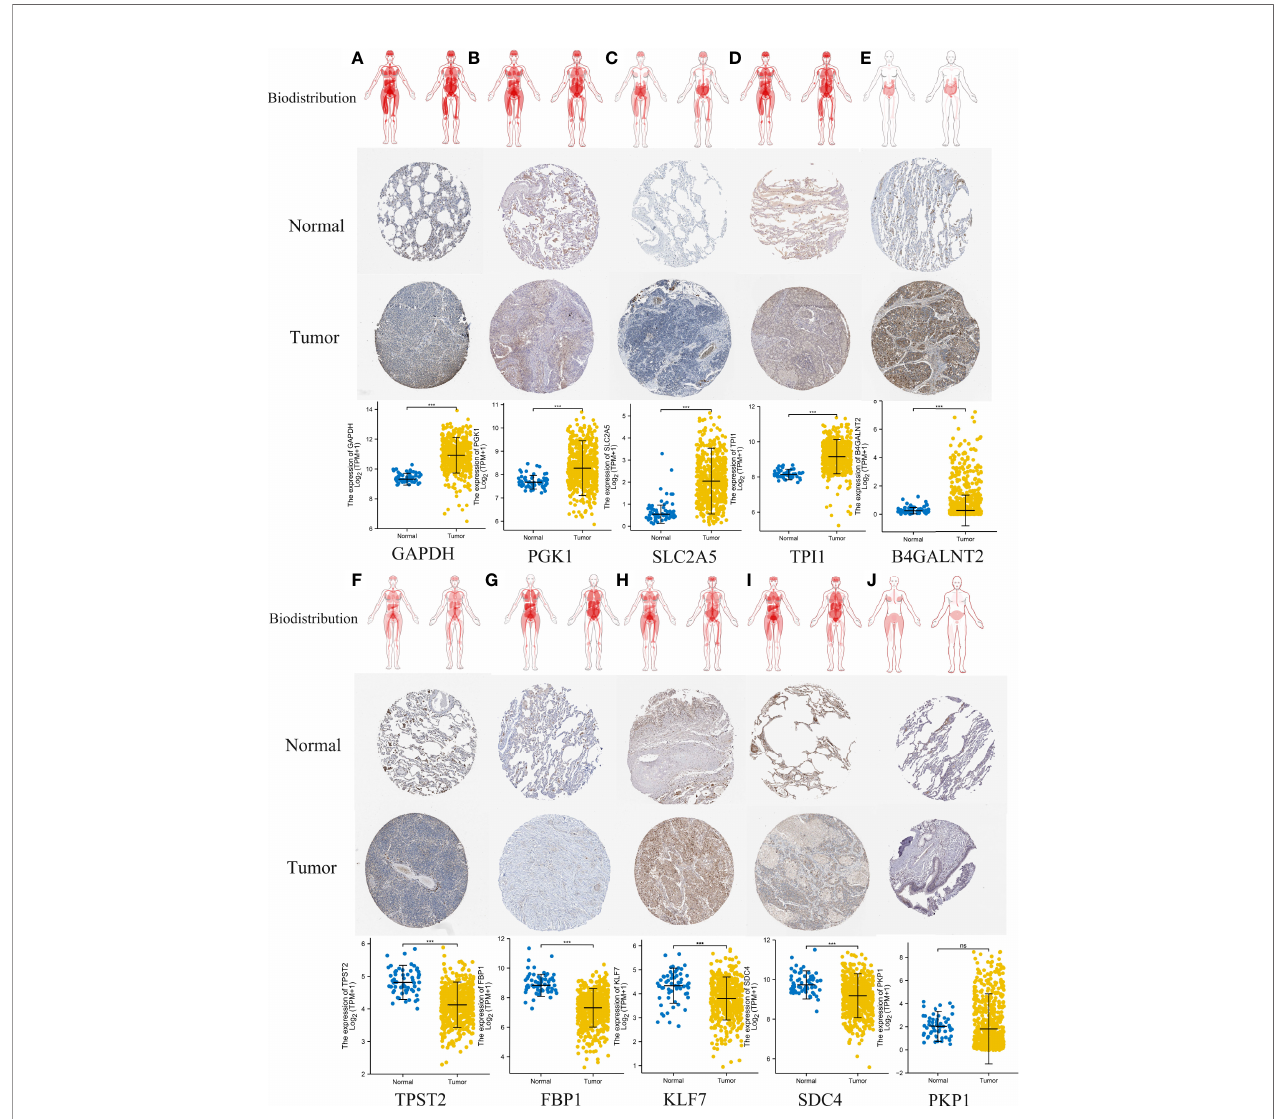
FIGURE 13 | Comparison of hypoxia-associated gene expression at the protein level. From top to bottom, panels (A – J) represent biodistribution, IHC staining of protein expression in normal tissues and LUAD tumors tissues, and comparison of expression levels between normal tissues and LUAD tumors tissues for each gene, respectively. (A) GAPDH. (B) PGK1. (C) SLC2A5. (D) TPI1. (E) B4GALNT2. (F) TPST2. (G) FBP1, (H) KLF7, (I) SDC4. (J) PKP1. ***p < 0.001; ns, not signi fi cant, p >